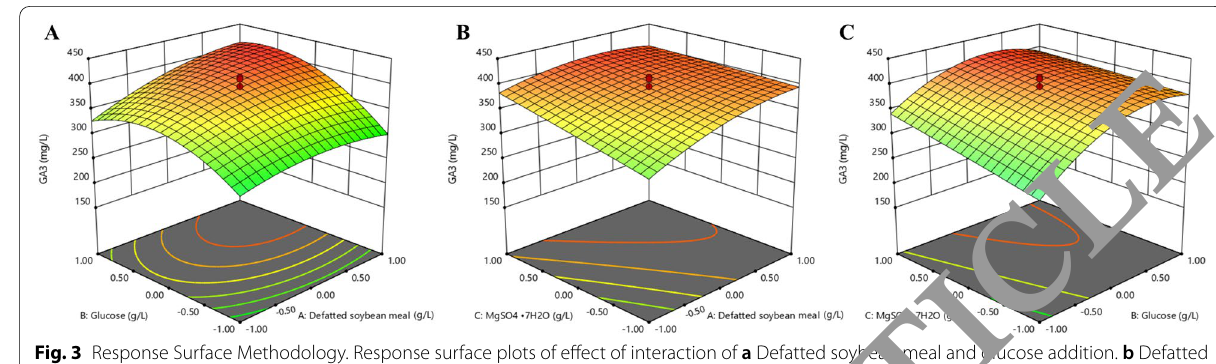
Fig. 3 Response Surface Methodology. Response surface plots of effect of interaction of a Defatted soybean meal and glucose addition. b Defatted soybean meal and MgSO